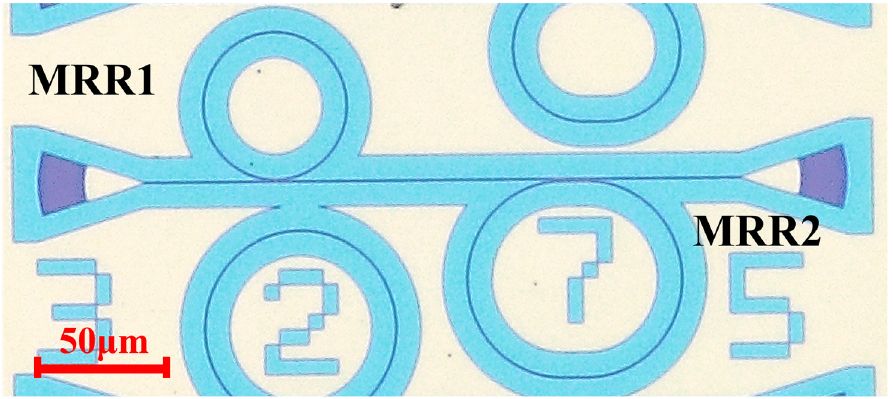
Figure 1. Microscopic image of the dual-MRR temperature sensor.